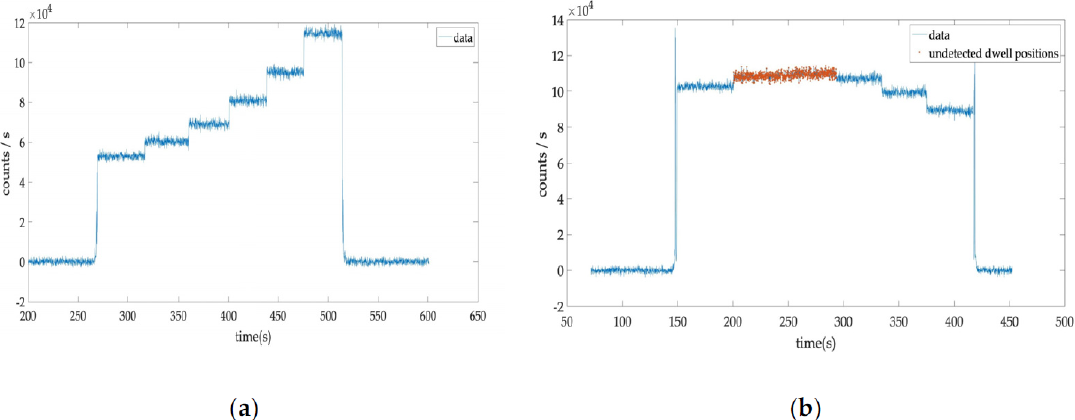
Figure 6. ( a ) An example of six dwell position signals clearly differentiated; ( b ) an example with two dwell positions signals undistinguished due to their similar count rate.